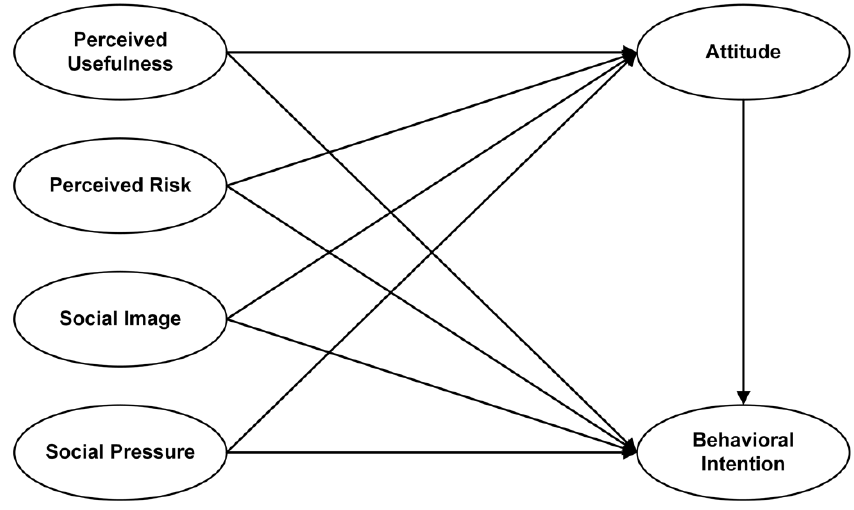
Figure 1. Research Model.